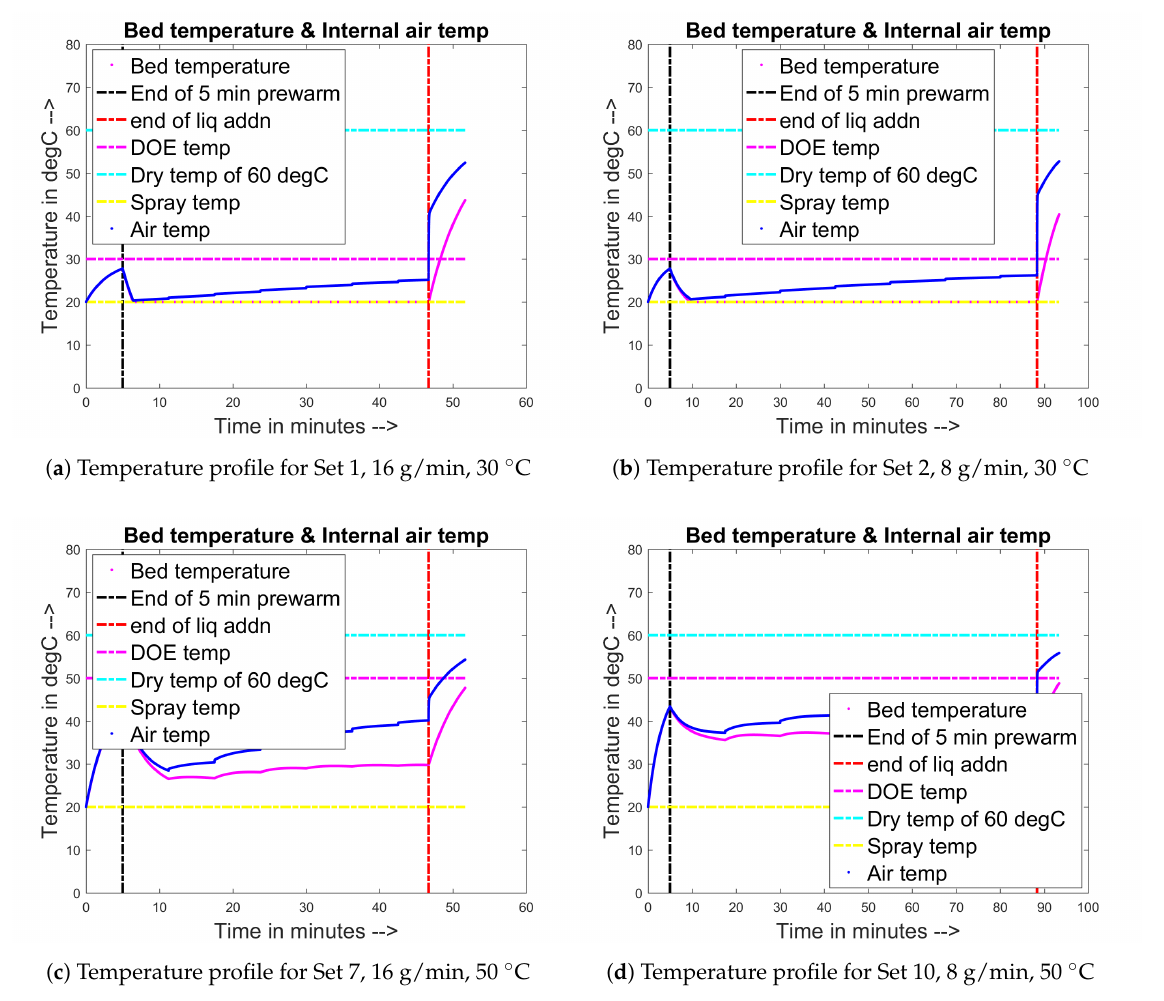
Figure 7. Plots showcasing the temperature profiles of the particle bed for the various experimental